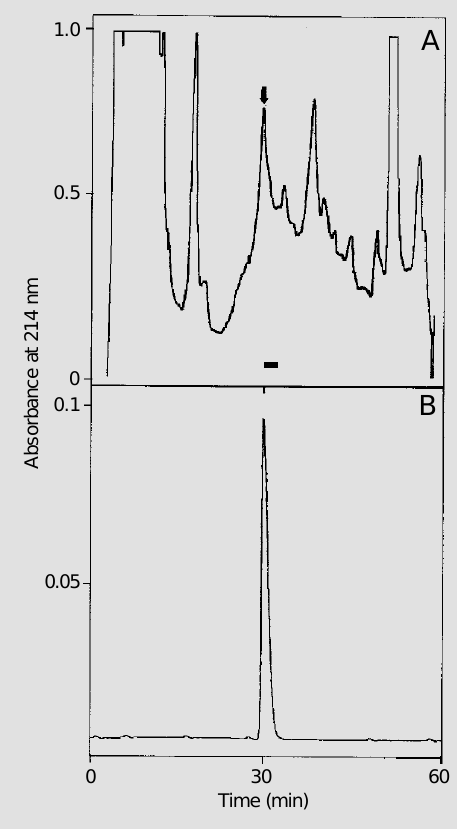
Figure 1 - A , HPLC elution pro- file of a crude sample from Bu- nodosoma granulifera . The sample was dissolved in TFA at a proportion of 1:4 (w:v). After centrifugation at 17,000 g for 60 min, the supernatant fraction was injected into an HPLC appa- ratus with a C 18 column (Shim- pack 25 x 250 mm) eluted with a 0-40% gradient of acetonitrile containing 0.05% TFA, over a period of 30 min at a flow rate of dicates the effluent containing neurotoxic activity that were combined. B , HPLC elution pro-